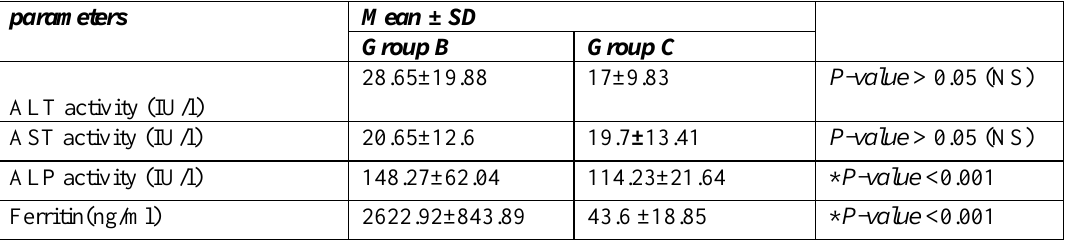
Table2. Differences in Serum ALT, AST, ALP and Ferritin between Group B and C.